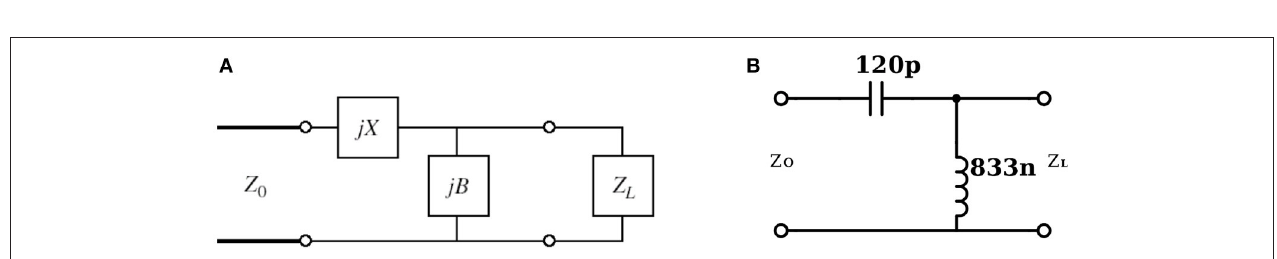
FIGURE 6 | Measured voltage (purple solid) and current (green solid) waveforms of the TinyPR with plasma running. Assuming majority of the power is transferred at fundamental frequency, the extracted fundamental components of the voltage (purple dash) and current (green dash) are used to calculate impedance magnitude and phase.